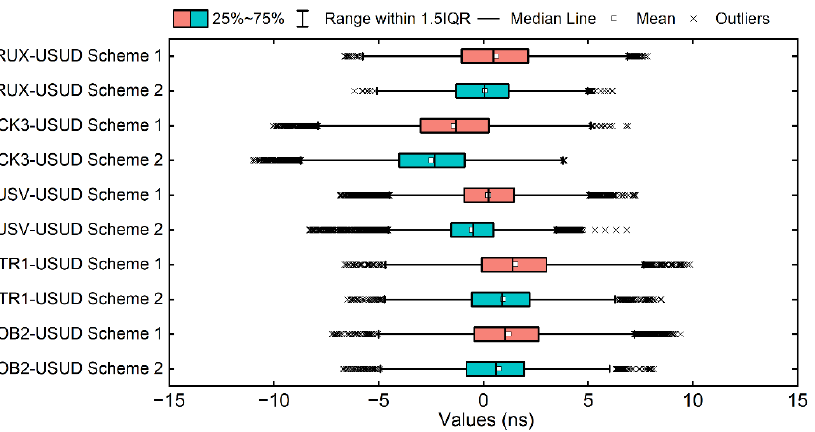
Figure 12. The clock difference between the SF SPP time transfer solutions and GBM PPP time transfer solutions for five time links with the two schemes.